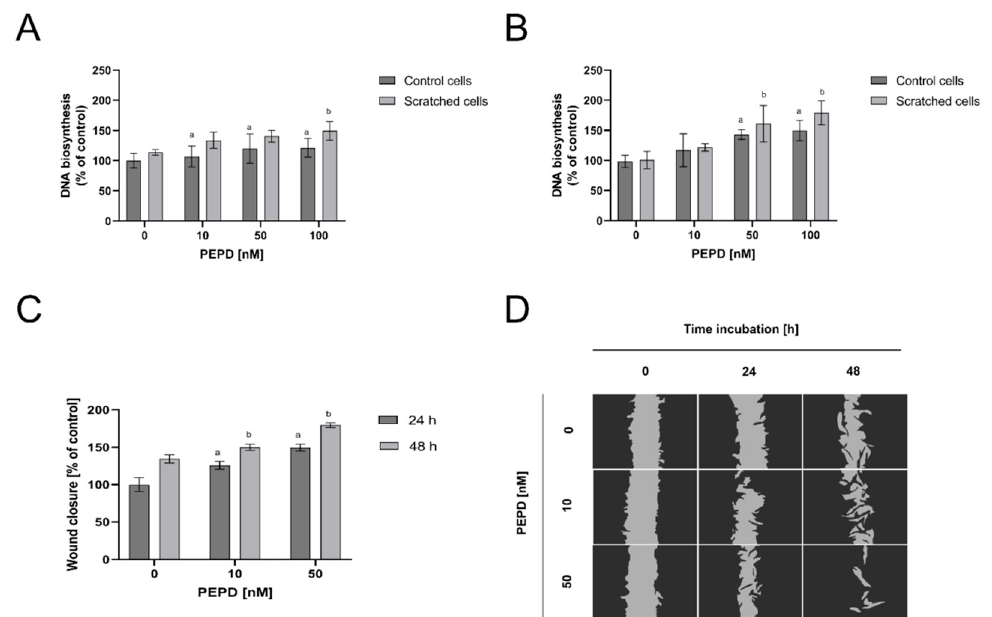
Figure 2. Extracellular PEPD-dependent proliferation and migration of fibroblasts in a model of closure/scratch assay. ( A , B ) Control, as well as “scratched” fibroblasts, were treated with PEPD (1–100 nM) for 24 h and 48 h, and proliferation was evaluated using CyQuant Proliferation assay. ( C , D ) PEPD-stimulated fibroblasts migration was calculated using ImageJ software (https://imagej.nih.gov/ij/) vs. control. PEPD-treated cells were scratched and monitored using an inverted microscope (40 × magnification) at 0, 24, and 48 h. Mean values ± SD of three experiments done in replicates are presented. The results are significant at a, b < 0.05, and indicates a vs. control (0 nM of PEPD) of control cells and part C of 24 h incubation, b vs. control (0 nM of PEPD) of scratched cells, and part C of 48 h incubation, respectively. PEPD—prolidase.